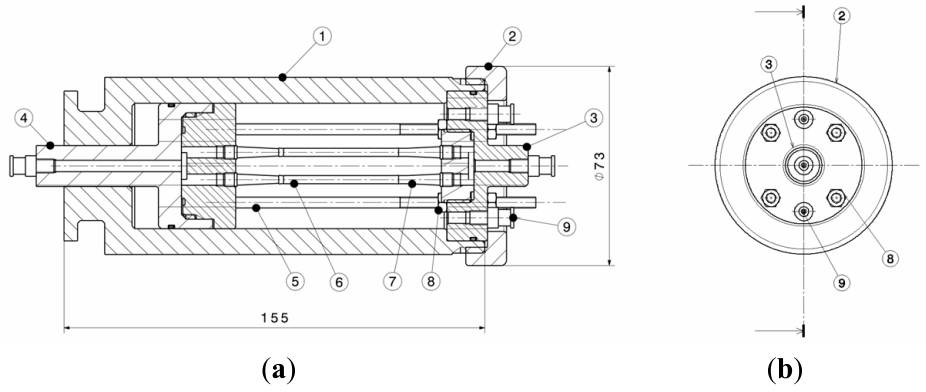
Figure 1. Transversal section ( a ) and top view ( b ) of the seeding device composed of a cylindric housing (1) with screw cap (2). The scaffold carrier with an outlet (3) and an inlet (4) is adjusted with four spacers (5) and allows the simultaneous perfusion of two tissue engineered vascular grafts (TEVGs) (6). The scaffolds are fixed with vessel cannulas (7) while the spacers are fixed with screw nuts (8). Luer-Lock-adapters (9) simplify filling processes and connection to the tubing